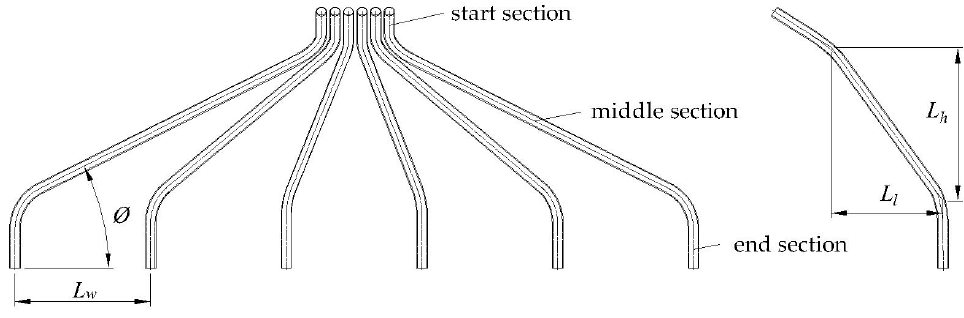
Figure 5. Structural diagram of seed tubes.